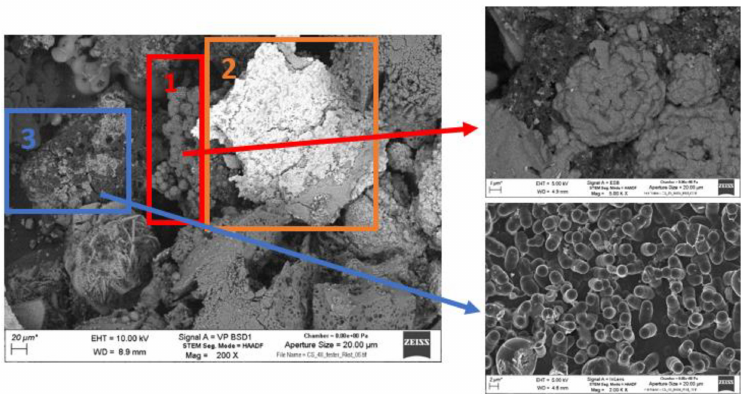
Figure 12. SEM recordings of solid deposits of experiment